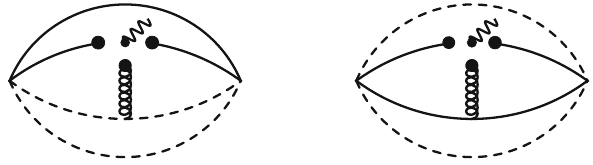
Fig. 1 The contributions (cid:3)¯ qq (cid:4) F αβ come from the terms ( x ) | 0 (cid:4) (cid:3) 0 | q i ( x ) ¯ q j ( 0 ) G n F , where the external lines denote the αβ photon field. Other diagrams obtained by interchanging of the heavy quark lines (dashed lines) or light quark lines (solid lines) are implied